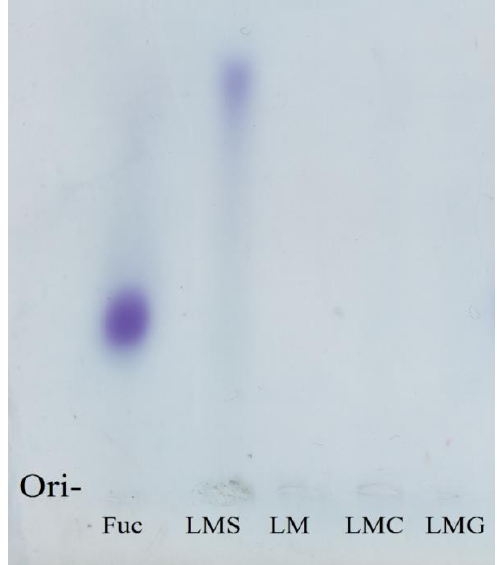
Figure 1. Electrophoretic profile of Fucan A (Fuc) from Spatoglossum schöederi seaweed; LMS: sulfated laminarin; LM: native laminarin; LMC: carboxylated laminarin; LMG: gallic acid–laminarin conjugate. Fifty micrograms of each sample were subjected to electrophoresis.